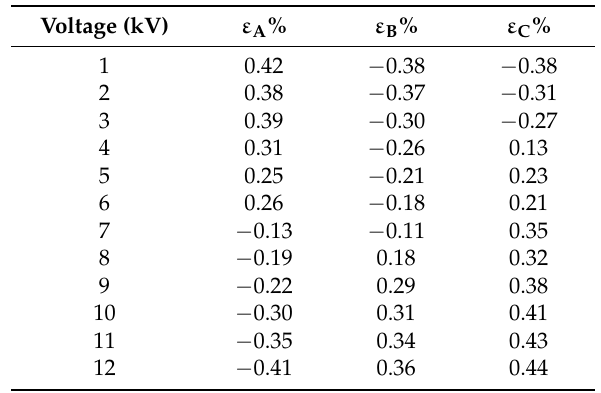
Table 2. Relative amplitude error.